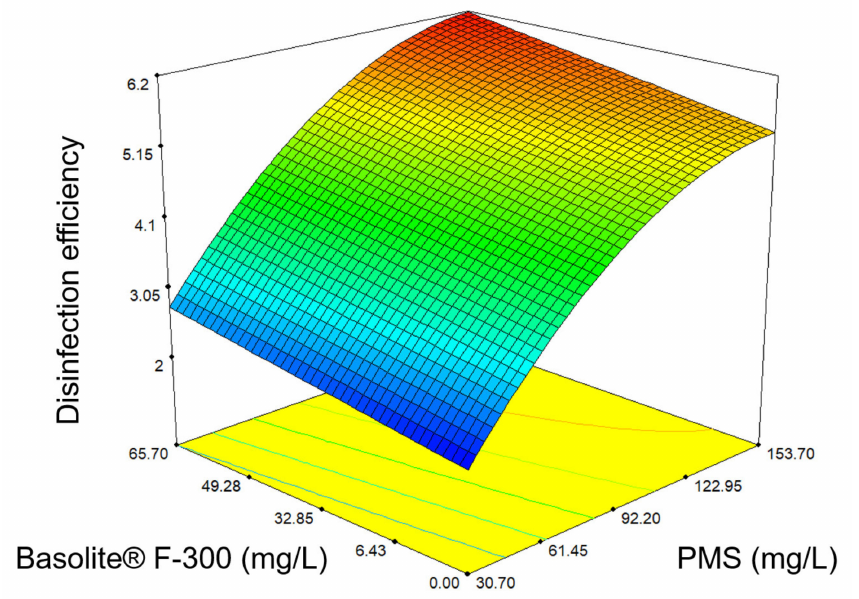
Figure 2. The 3D surface plot in which the response is the E. coli disinfection efficiency ( − log(N/N 0 )) after 5 min, in the function of the PMS and Basolite ® F-300